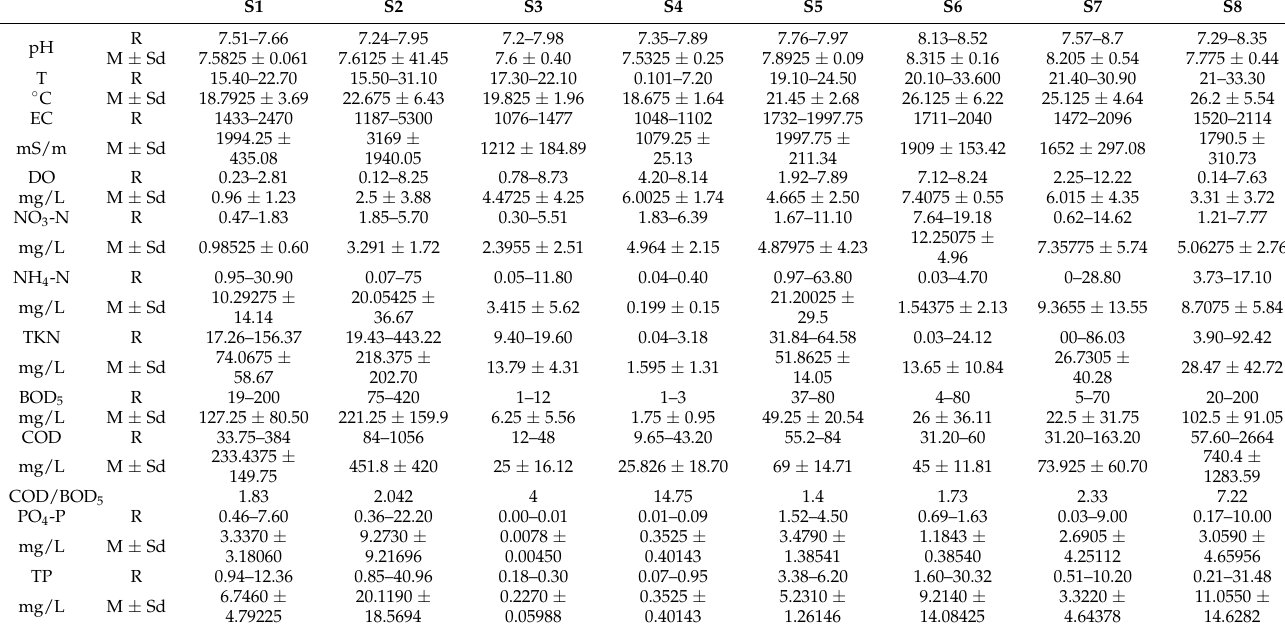
Table 3. The results of the evaluation of the physicochemical parameters